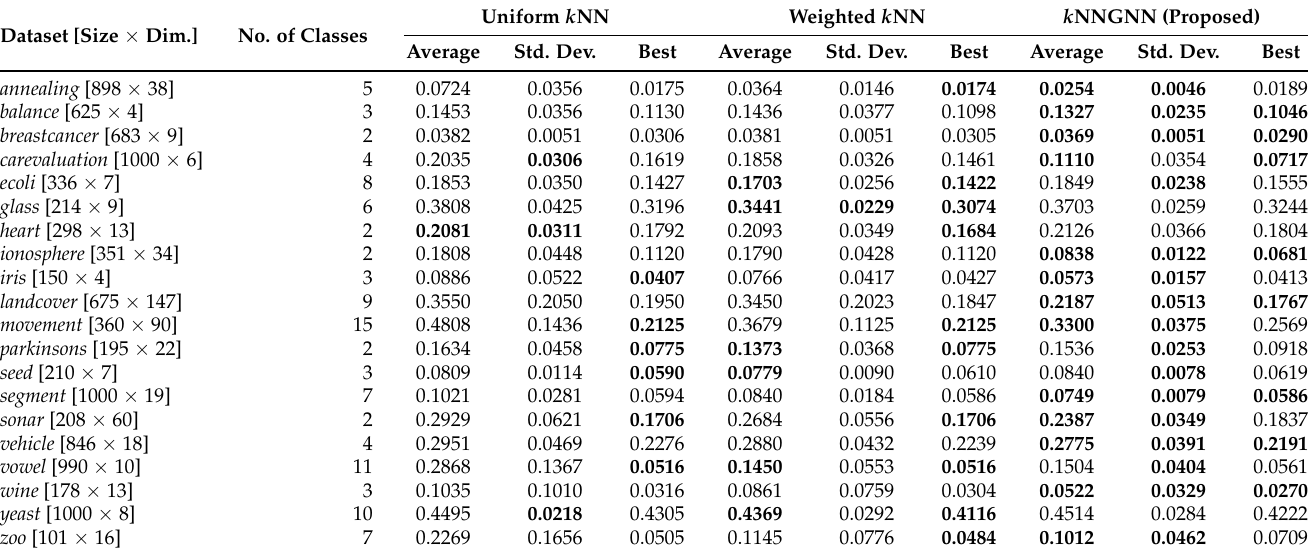
Table 1. Summary statistics of the error rate over different hyperparameter settings on the classification datasets. Dataset [Size × Dim.]